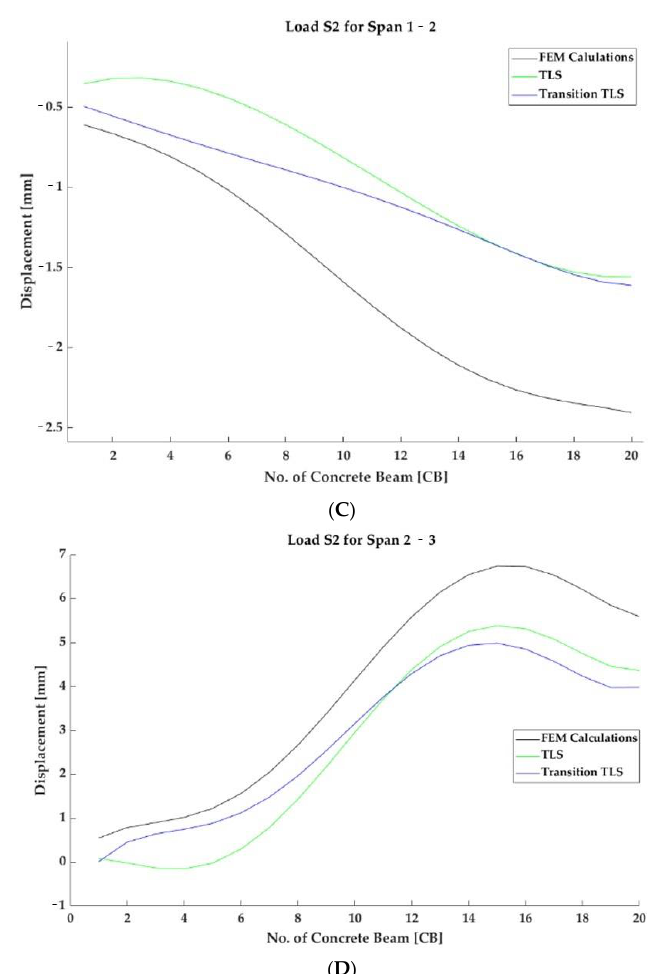
Figure 15. Displacement results for two loads in the cross-section for each span shown for numerical calculations, a laser scanner, and a scanner aggregated with potentiometric sensors. The symbols denote ( A ) S1 load for the 1 – 2 span, ( B ) S1 load for the 2 – 3 span, ( C ) S2 load for the 1 – 2 span, and ( D ) S2 load for the 2 – 3 span.